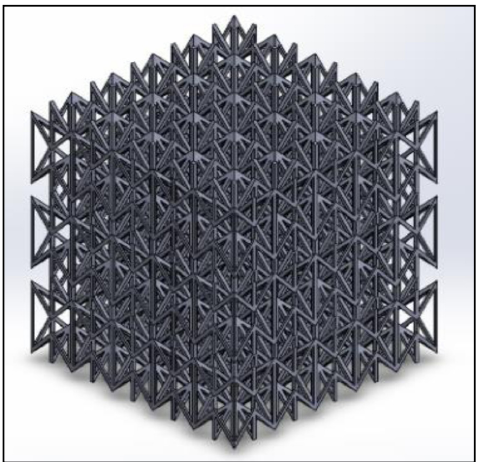
Figure 2. The isometric view of the optimized model.